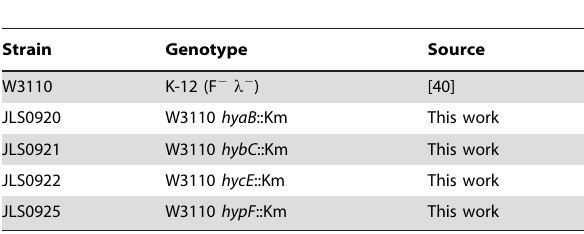
Table 1. E. coli K-12 strains used in this